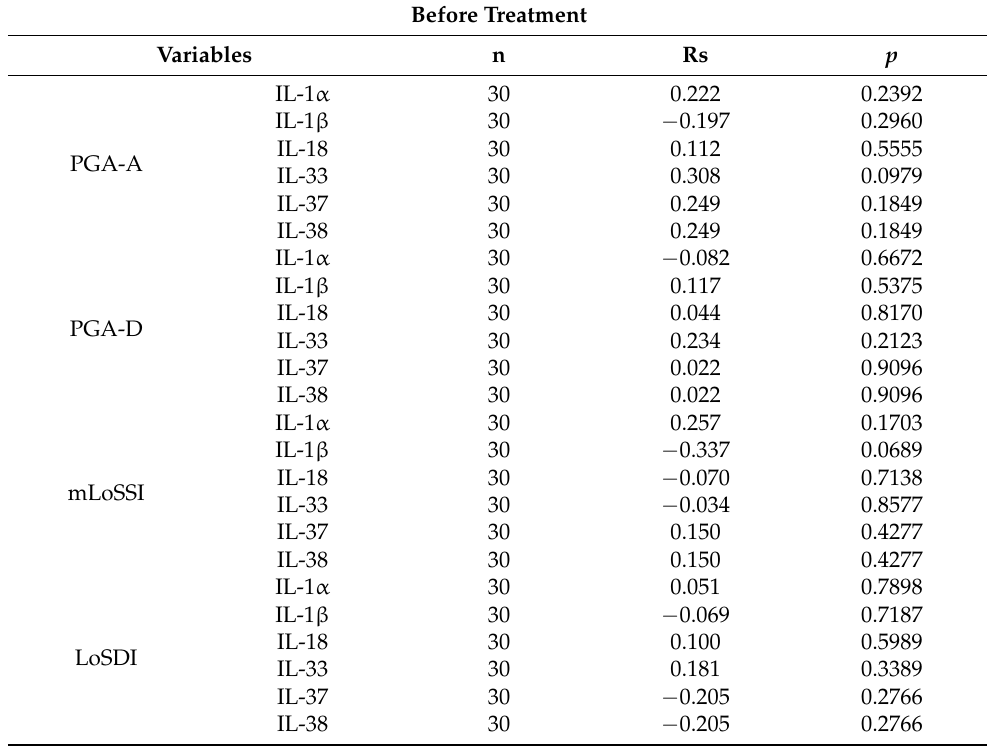
Table 9. Correlations between disease-targeted measures and levels of selected cytokines in LoS group before